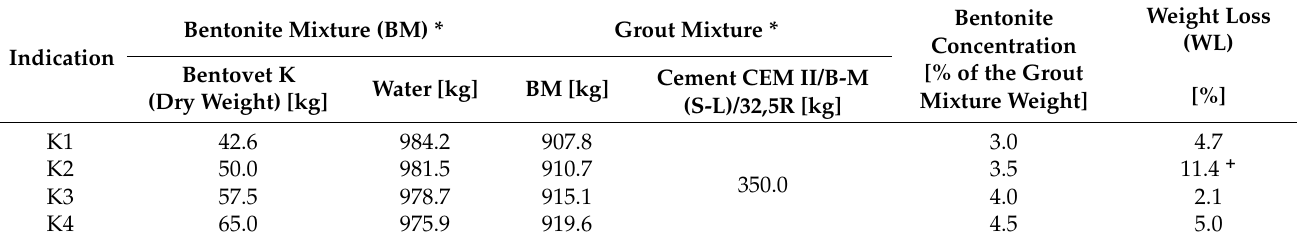
Table 2. Composition and WL of grout mixtures based on Bentovet